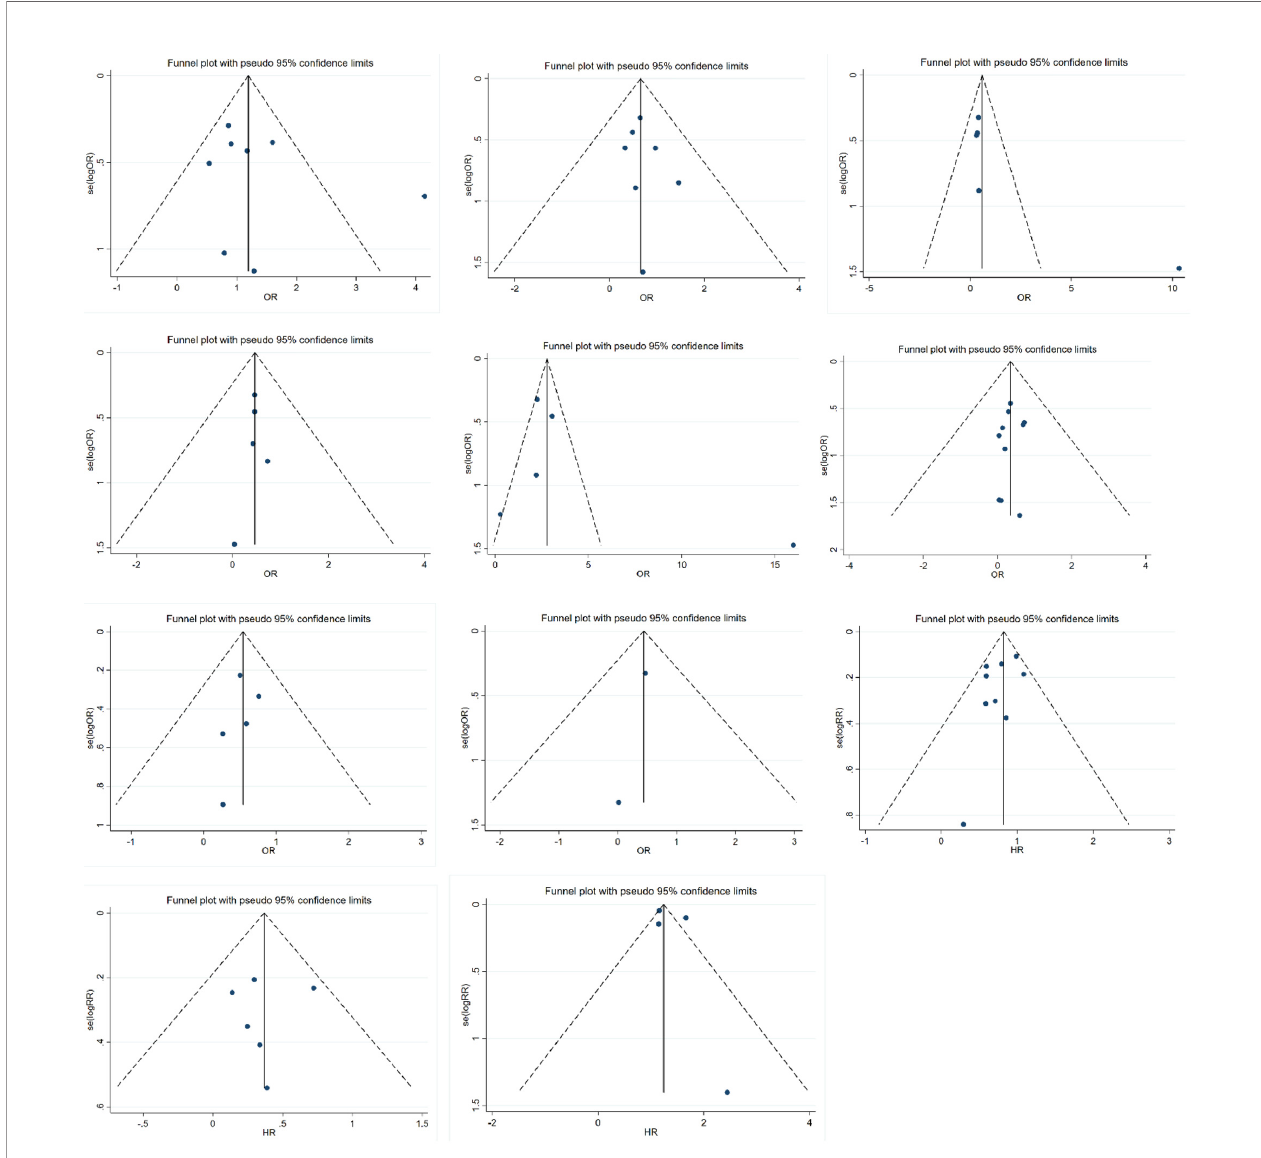
FIGURE 6 | Funnel plots of meta